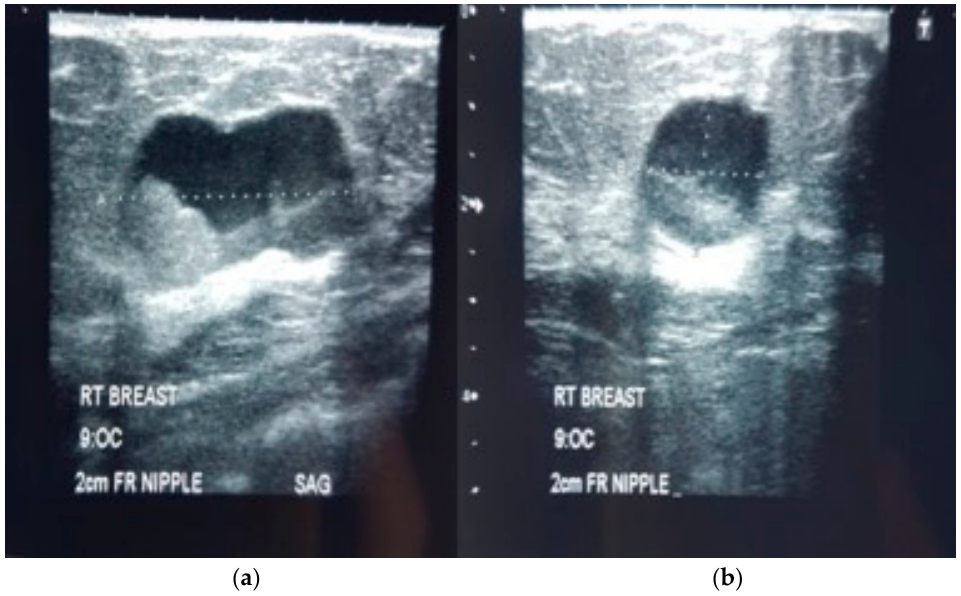
Figure 2. Sagittal ( a ) and axial ( b ) ultrasound views of the right breast show a heterogenous mixed solid cystic lesion with an irregular margin of the solid component at the 9 o’clock (OC) position. Histopathological evaluation (HPE) of the biopsy revealed a right papillary neoplasm. The patient was counseled for excision of the lesion, and she agreed to right wide local excision (WLE). She was also informed and understood about the possibility of a second surgery involving the right breast. The HPE of the surgery came out as right encapsulated papillary carcinoma (Figure 3) with estrogen (ER), progesterone (PR) and HER2 receptors positive. Unfortunately, the margins were involved with focal infiltration on HPE. Therefore, she then underwent a second surgery; right mastectomy with right axillary clearance (MAC) a month later.